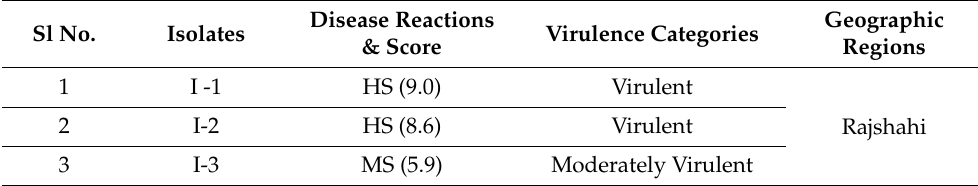
Figure 4. Typical symptoms of red rot disease on inoculated sugarcane variety, Isd 28 under field trial condition 60 days after inoculation. ( a ) Disease symptom from three virulence groups of 41 C. falcatum ( b ) severe internal symptom induced by virulent isolate ( c ) Moderate internal symptom induced moderately virulent isolate ( d ) mild internal symptom induced less virulent isolates ( e ) Un-inoculate cane, ( f ) Conidia of C. falcatum under compound microscopes (100×) after re-isolation from red rot infected cane tissue. The arrow indicated the point of inoculation. Table 4. Disease reactions and virulence categories of C. falcatum isolates from Bangladesh on infected sugarcane variety, Isd